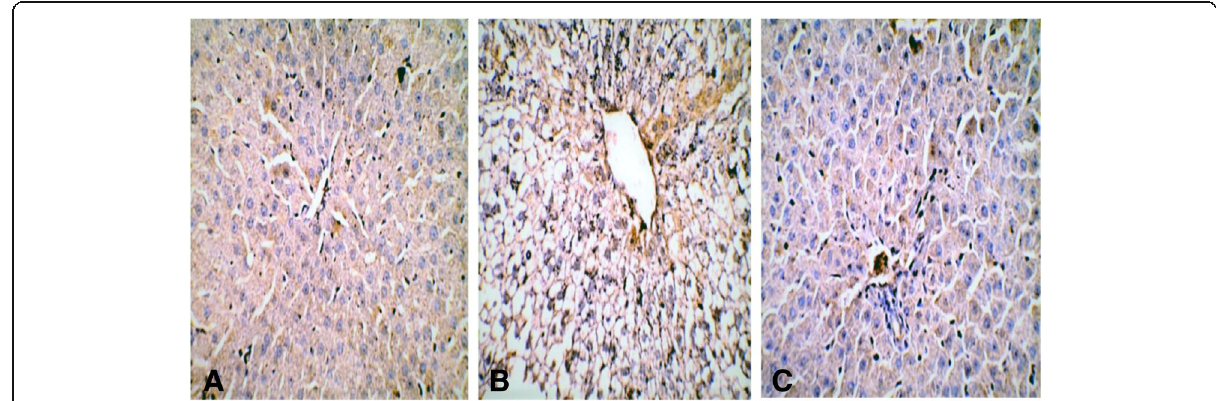
Fig. 4 Expression of caspase 3 immunohistochemical staining (× 400). a A section obtained from the liver of a control rat shows caspase 3- immunolabeled hepatocytes were rarely present. b A section obtained from the liver of a rat treated with 500 mg/kg COC shows a decreased number of caspase 3-immunolabeled hepatocytes were observed around central veins, identified by brown staining. c Sections taken from the liver of a rat treated with curcumin followed by 500 mg/kg COC shows caspase 3-immunolabeled cells were slightly similar to the control